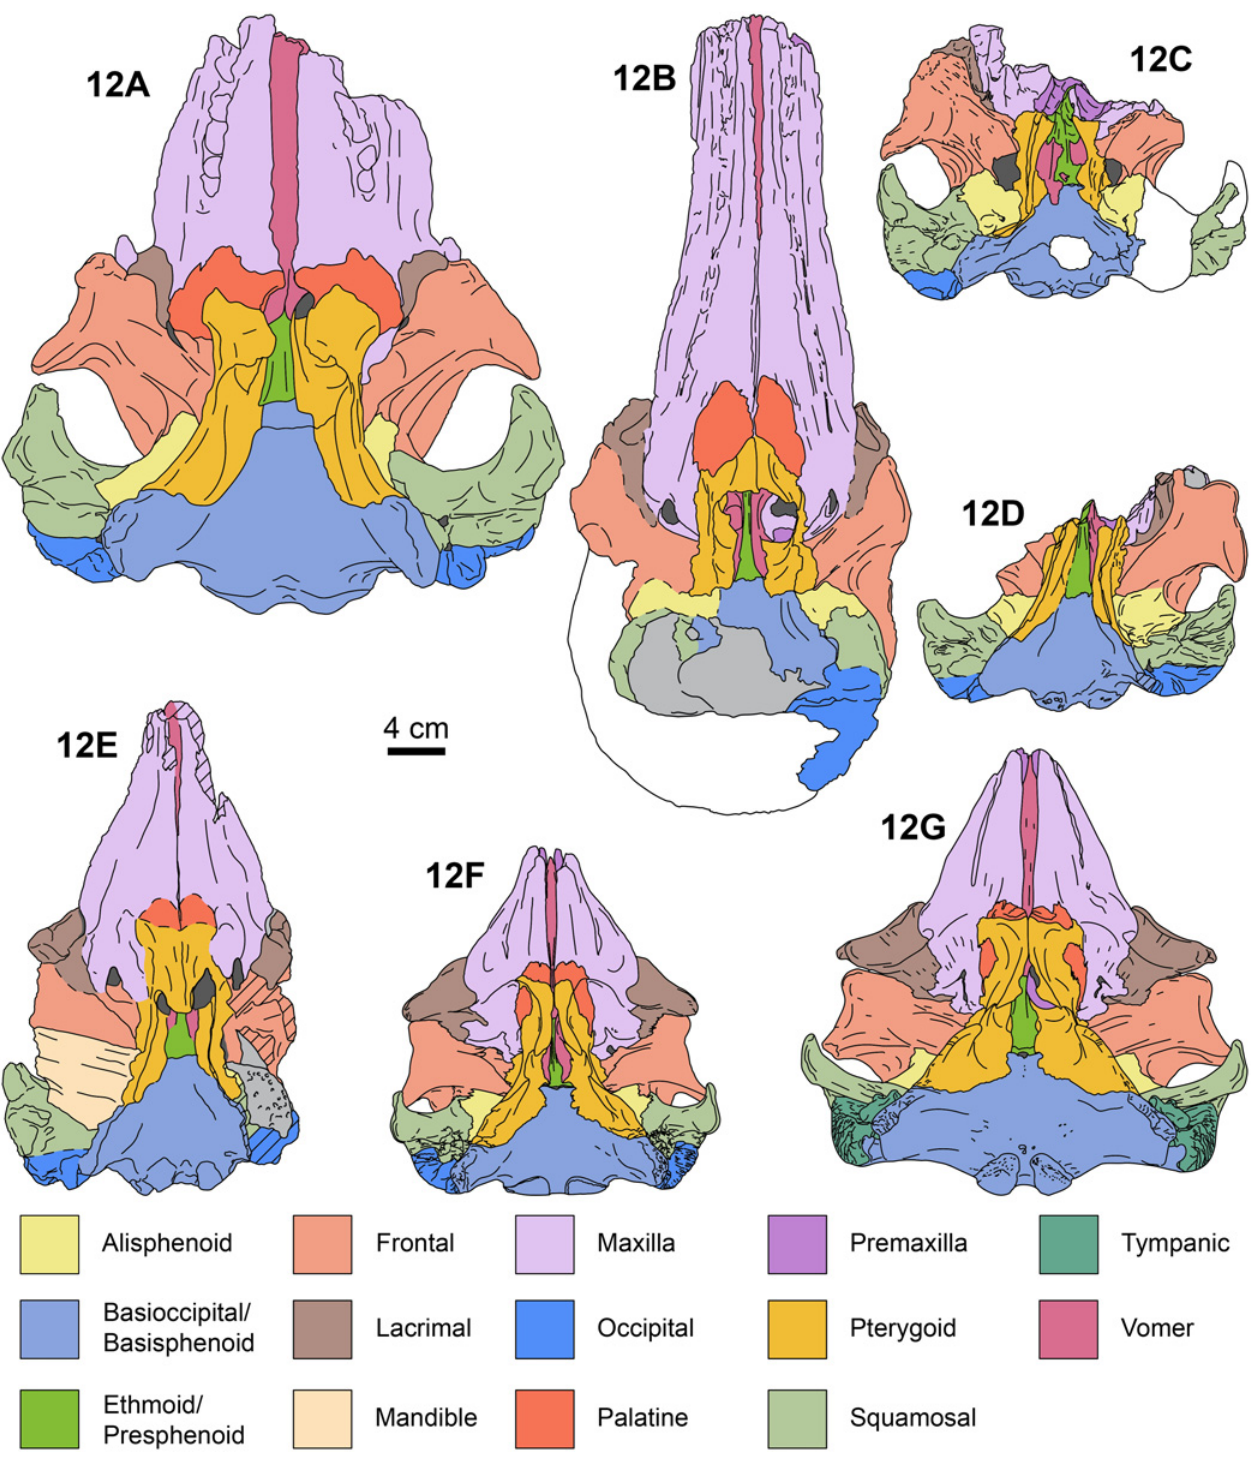
Fig 12. Ventral views of kogiid skulls. Aprixokogia kelloggi (USNM 187015), 12A, Scaphokogia cochlearis (MNHN PPI 229), 12B, Praekogia cedrosensis (UCMP 315229), 12C, Nanokogia isthmia gen. et sp. nov. (UF 273554), 12D, and (UF 280000), 12E, Kogia sima (LACM 47142), 12F, and K . breviceps (LACM 95745), 12G. Each bone is color-coded for ease of comparison. Areas in white are reconstructed, light gray areas are covered with sediment; diagonal lines denote broken surfaces. Illustrations based on direct observations of the specimens listed.